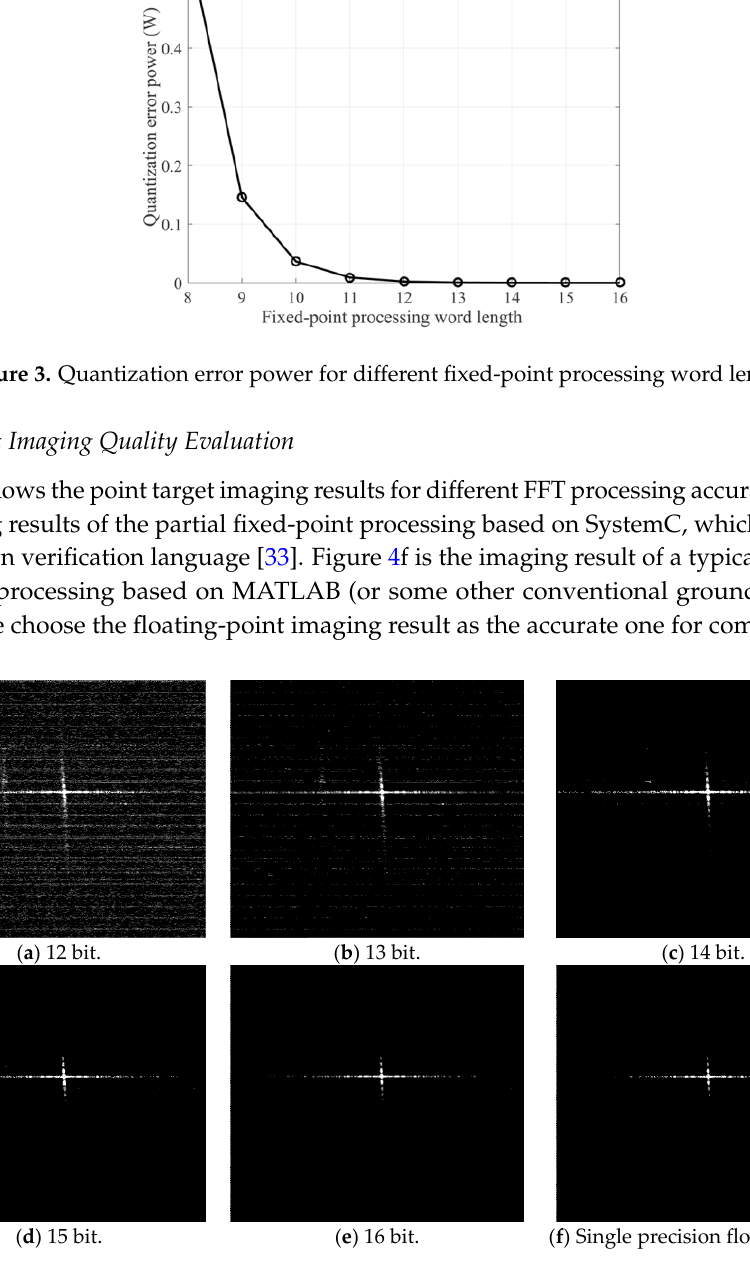
Figure 4. Point target imaging results for different FFT processing accuracies. ( a – e ): 12–16 bit fixed- point FFT, ( f ) single precision floating-point FFT.